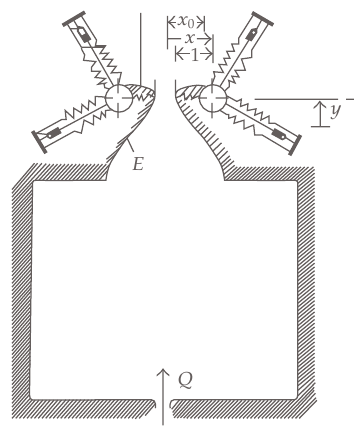
Figure 3: One-mass two-degrees-of-freedom model of the vocal cord (cid:4) 18 (cid:5)